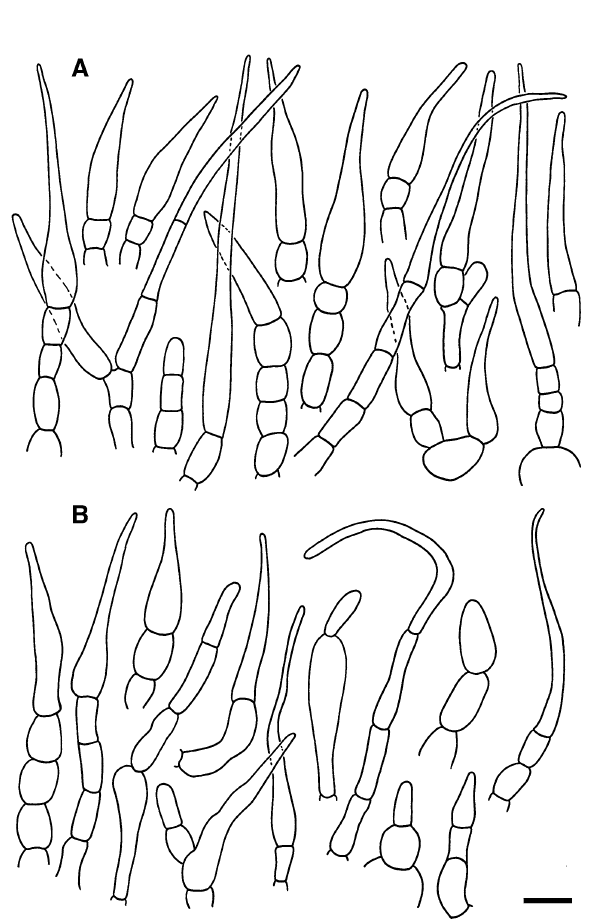
Figure 6. Elements of the pileipellis of Russula bellissima (holotype, FH 12-127). ( A ) Hyphal terminations near the pileus margin. ( B ) Hyphal terminations near the pileus centre. Scale bar = 10